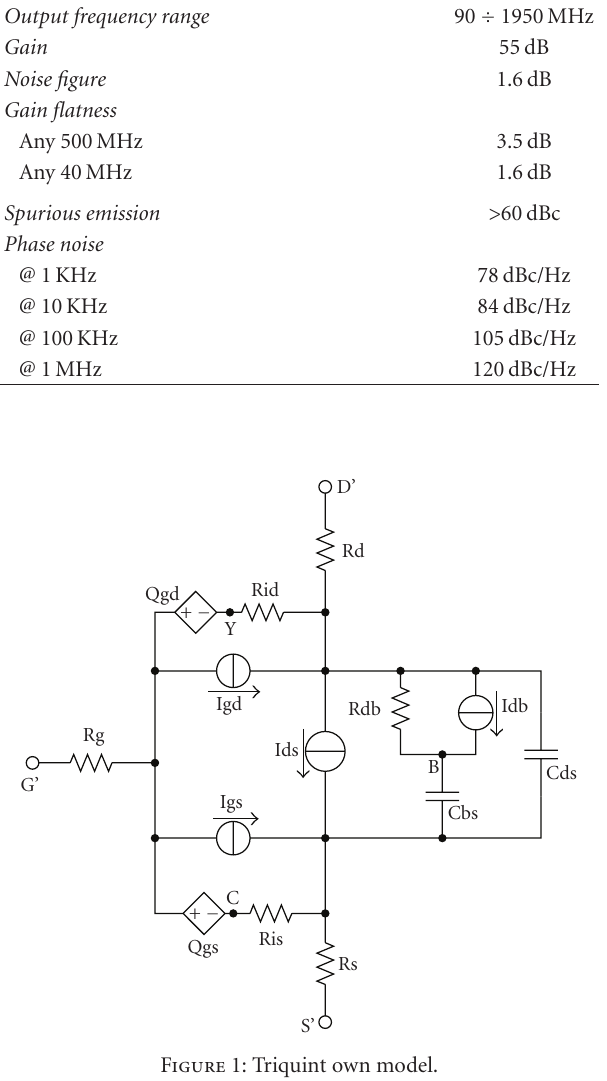
Figure 1: Triquint own